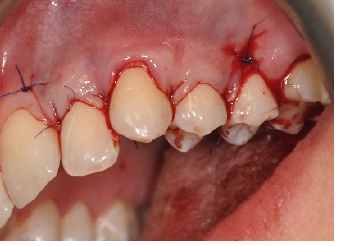
Figure 9. Coronal advancement of flap for recession coverage.